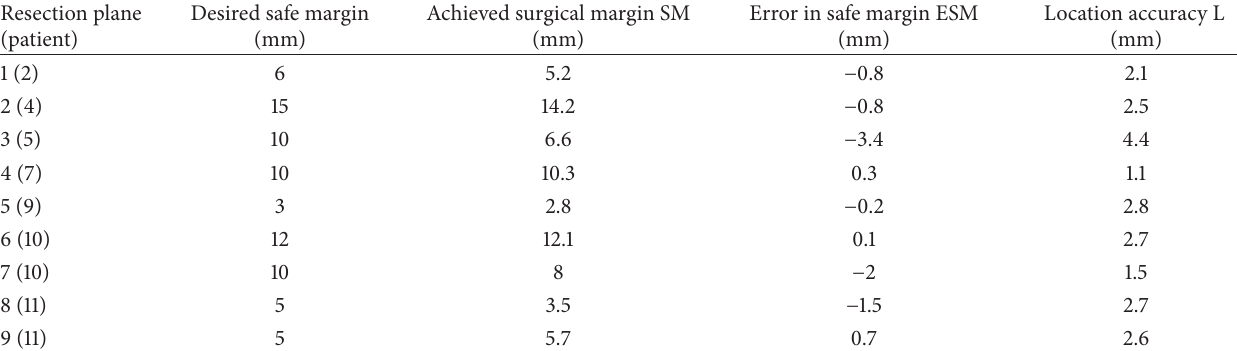
Table 2: Achieved surgical margins SM and location accuracy L.